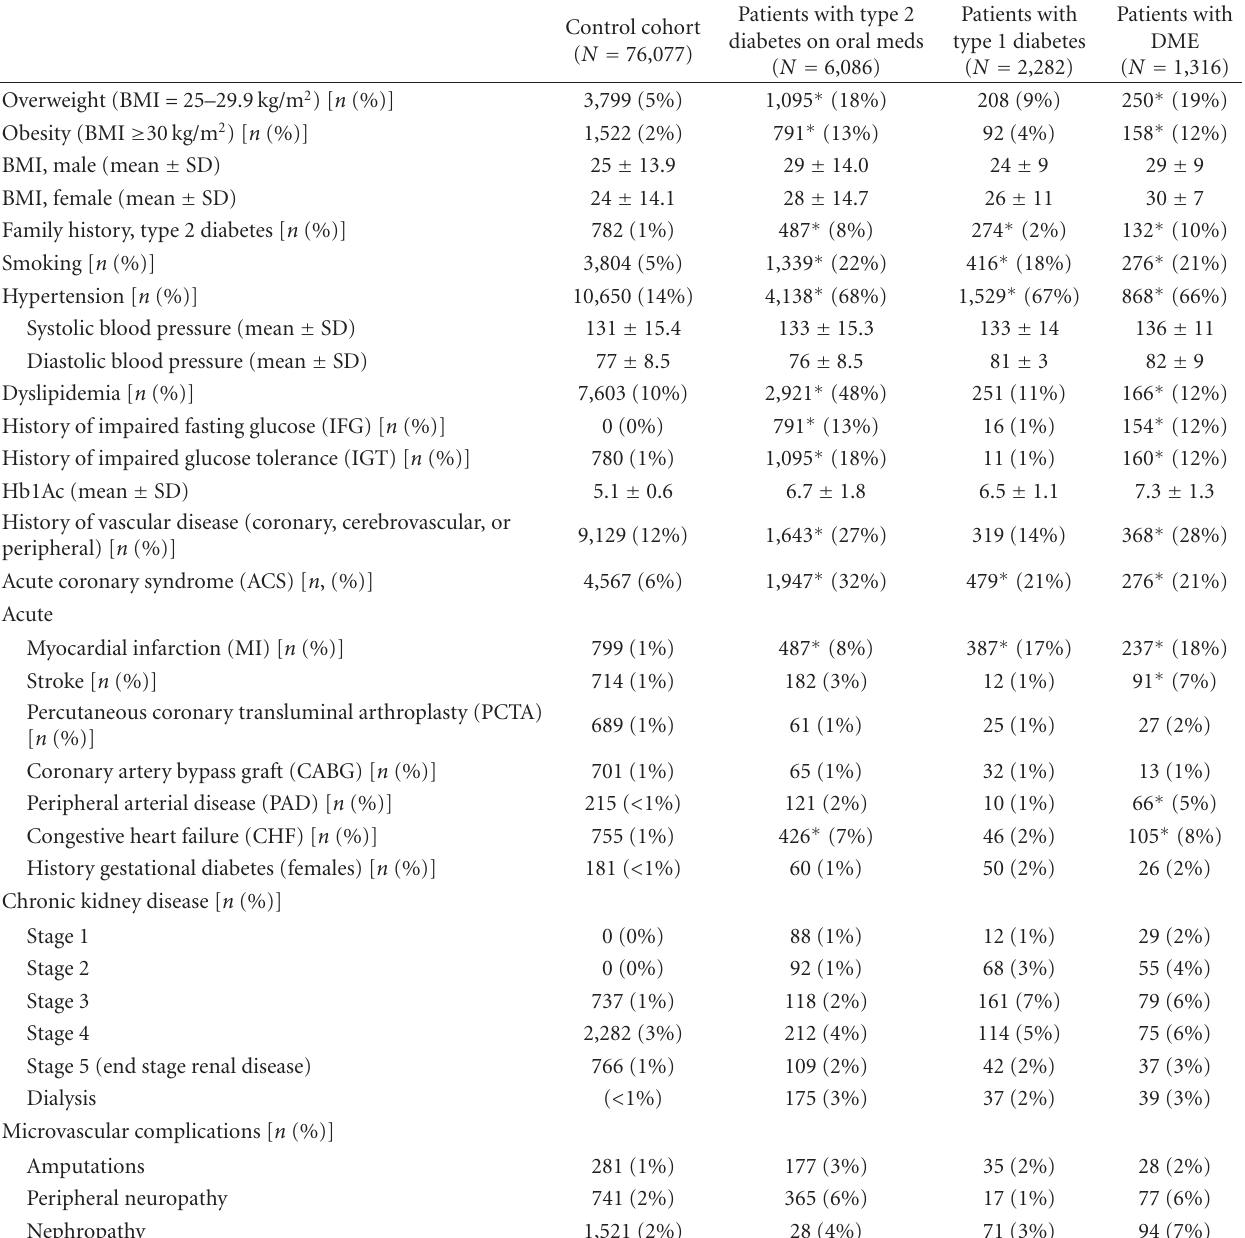
Table 2: Disease characteristics of the populations investigated.